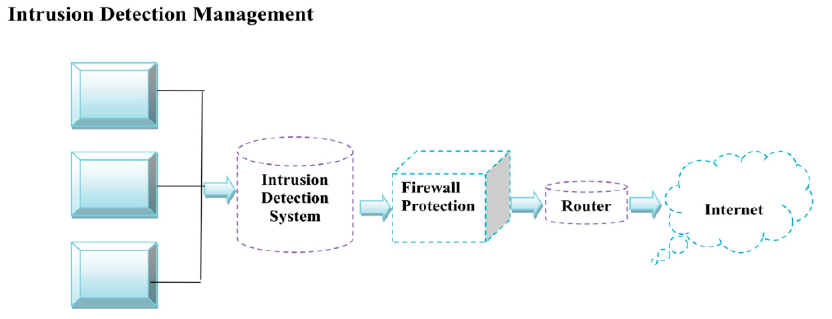
Figure 1. Working process of